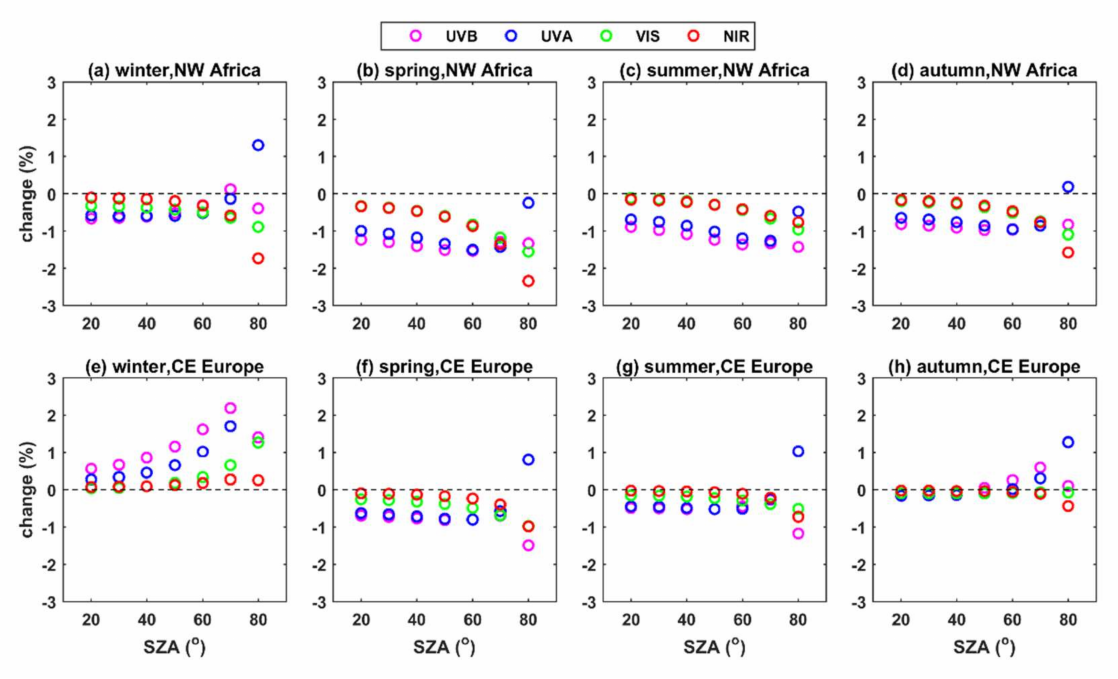
Figure 11. Change (in %) in the simulated GI reaching the surface due to the use of the LIVAS profiles instead of the default libRadtran